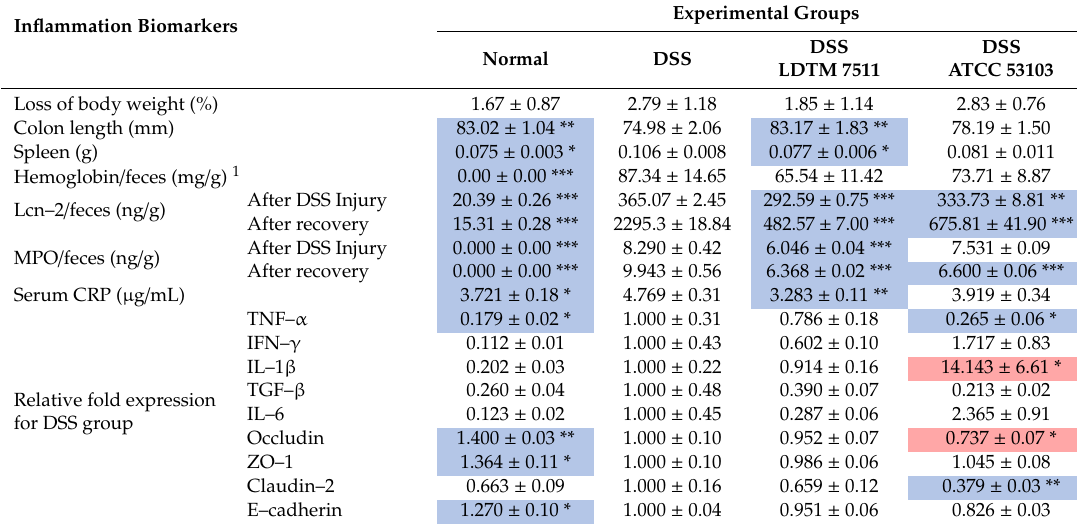
Table 2. E ff ect of L. rhamnosus strains on an inflamed gut in a dextran sulfate sodium (DSS)-induced colitis murine